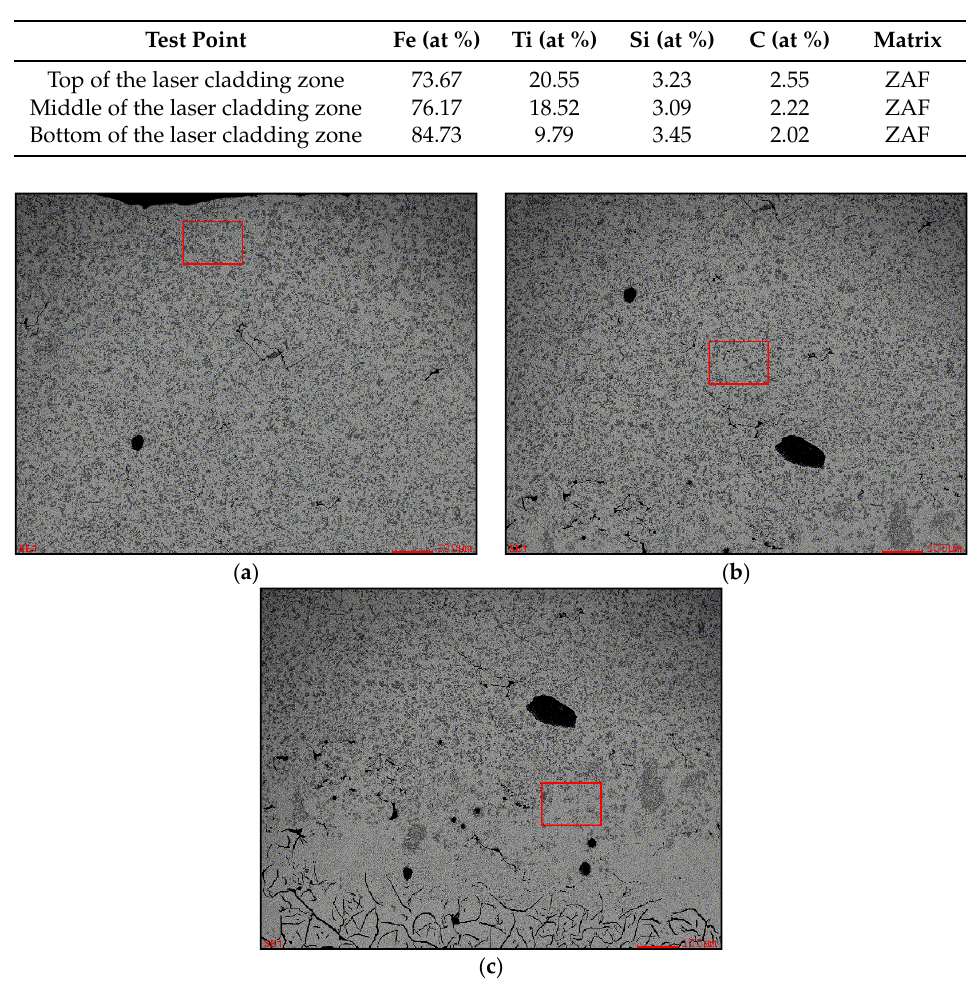
Figure 6. EDS area analysis at the different parts of the laser cladding zone. ( a ) Top of the laser cladding zone; ( b ) middle of the laser cladding zone; and ( c ) bottom of the laser cladding zone.